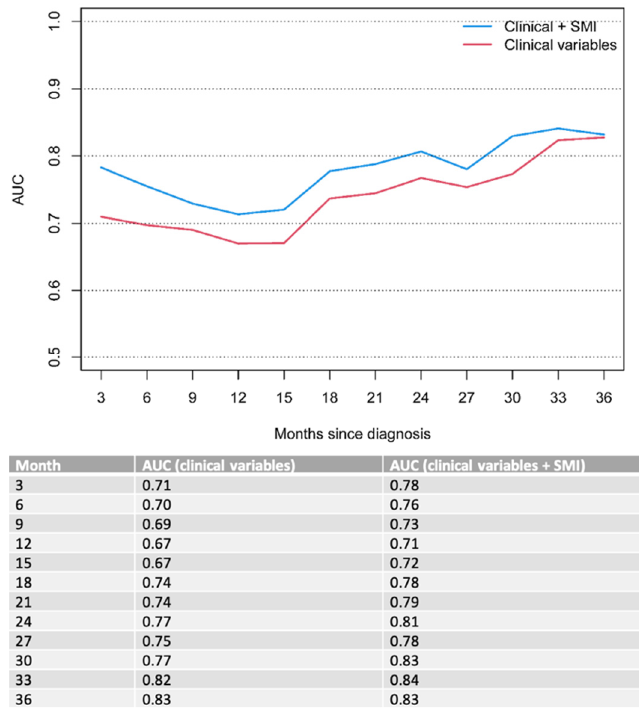
Figure 2. Time-dependent AUC for OS. Clinical variables include ECOG performance status and bone metastases.